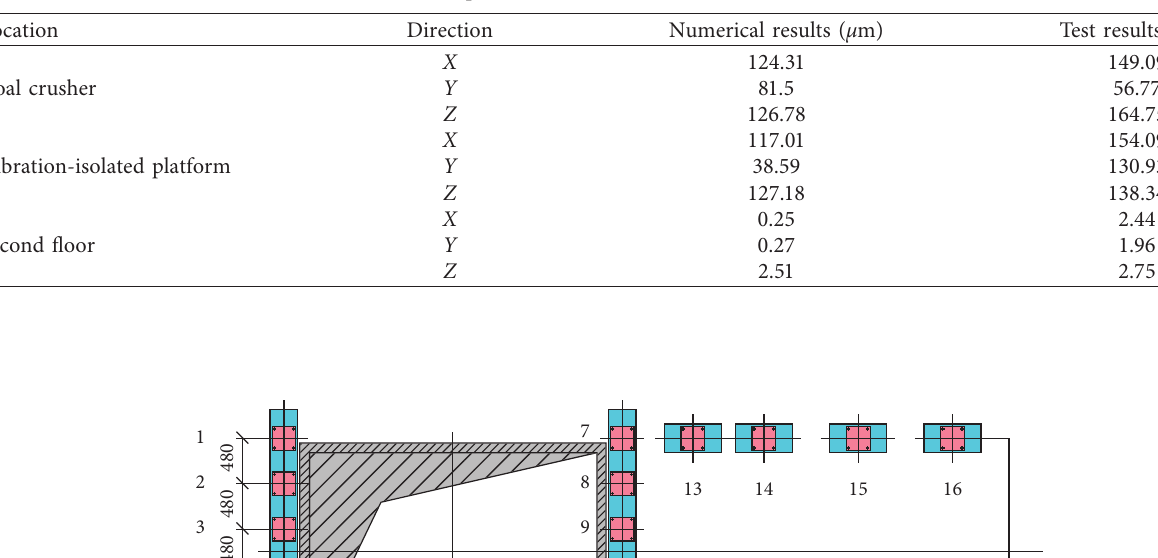
Table 6: Vibration displacements from numerical results and test results.